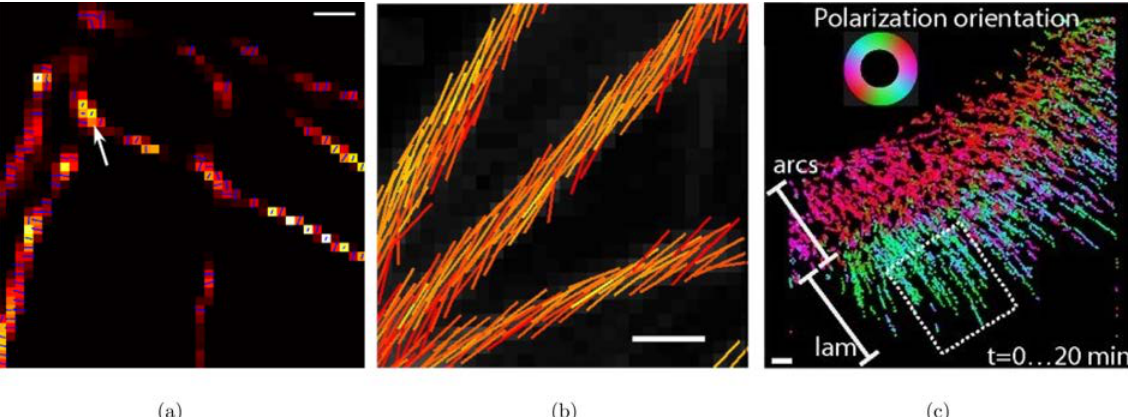
Fig. 4. Super resolution dipole measurement on actin samples; (a) SDOM results of actin in ¯xed cells. The dipole orientation is marked with arrows on each pixel. (b) Polar-dSTORM results of actin in ¯xed cells. The direction of line segments indicates the orientation of single dipoles.(c)TemporalprojectionoftrackingresultsofactininlivecellsbyinstantaneousFluoPolScope.Thedipoleorientationiscodedwith pseudo color in the color wheel. The bands corresponding to actin arcs (arcs) and the bands corresponding to lamellipodium (lam) behave di®erent polarization orientations (b) is adapted from Ref. 17 and (c) is adapted from Ref. 16. Scale bar: a, 200nm; b, 1.5 (cid:4) m; c, 1 (cid:4)